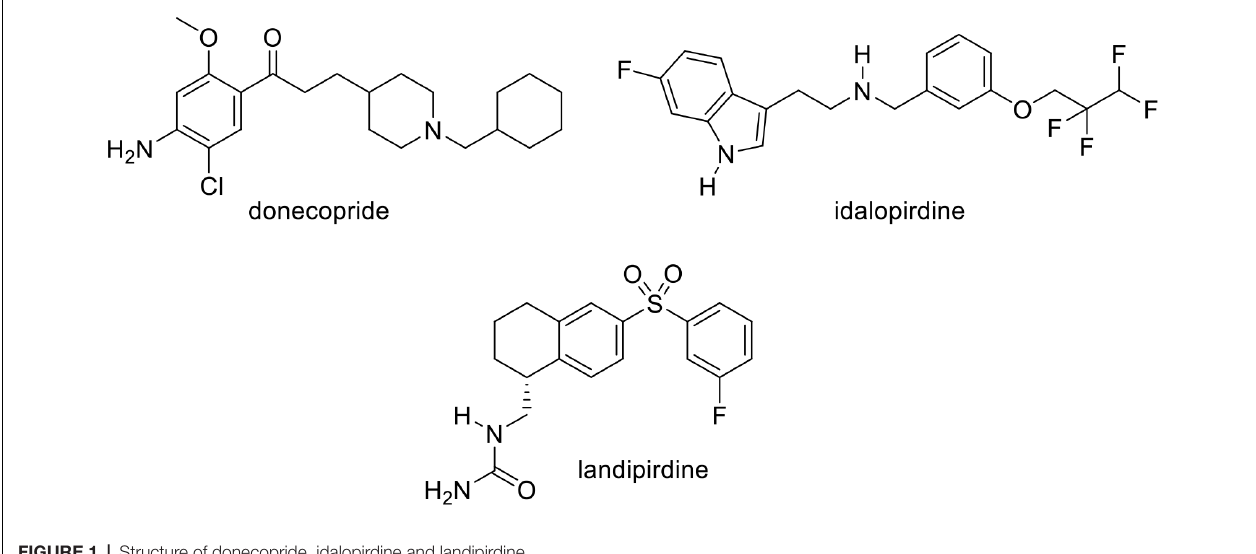
FIGURE 1 | Structure of donecopride, idalopirdine and landipirdine.